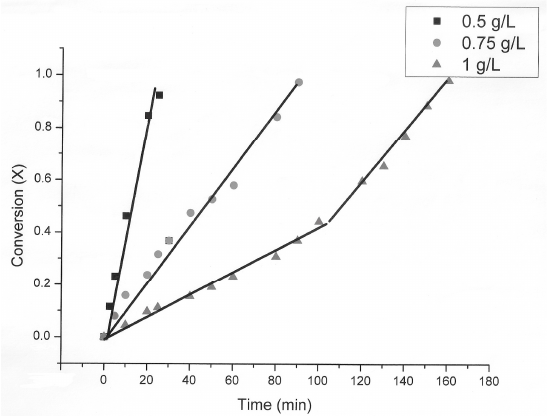
Figure 10. Effect of initial S 2 O 3 2 − concentration on thiosulfate transformation: [Cu 2+ ] initial , 0.053 g · L − 1 ; pH constant , 5; 60 °C; O 2 pressure, 1 atm.